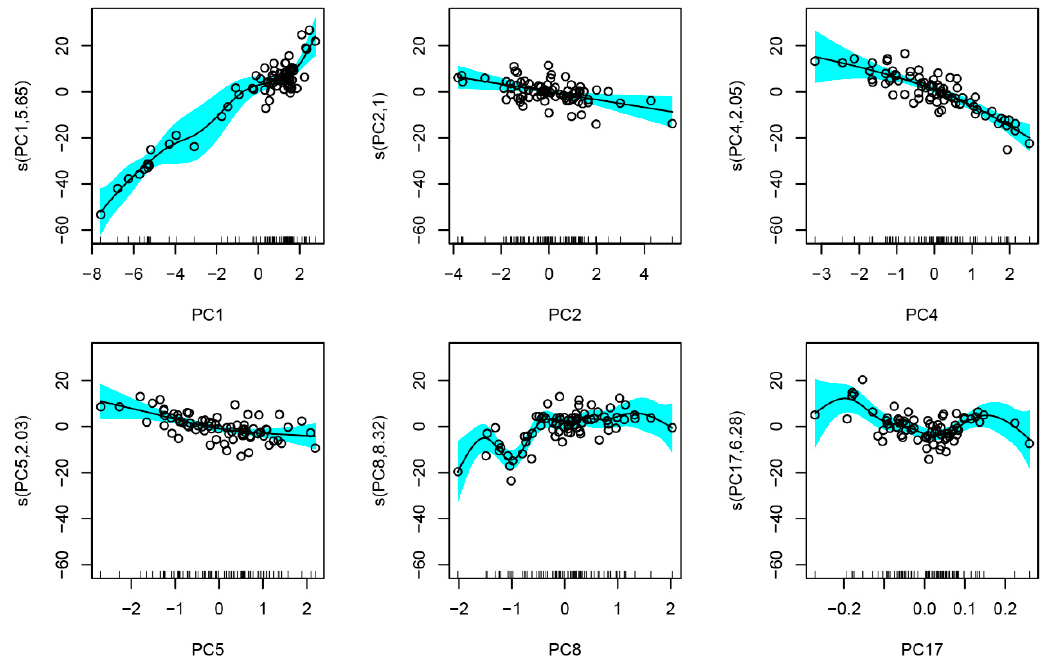
Figure 6. Results of PCA–GAM analysis. The x -axis represents the frequency of data; the y -axis represents the smooth fitted values. Degrees of freedom for linear or non-linear fits are in the parentheses on the y -axis. The solid line represents the fitted curve of each independent variable, the blue area represents the 95% confidence interval.